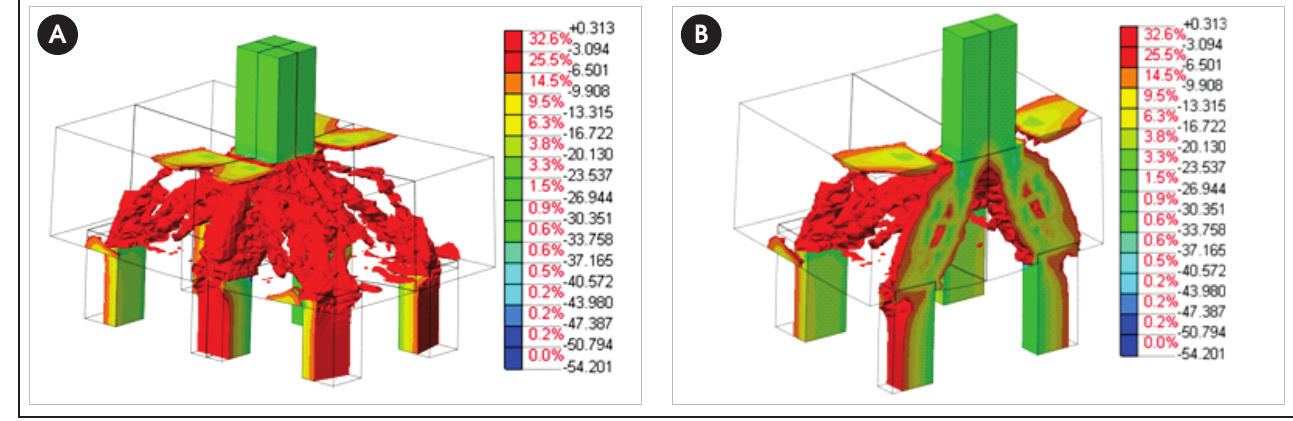
Figure 14 – Principal compressive stress. Surface where acts a stress of -6 MPa in pile cap B-1-30-600: